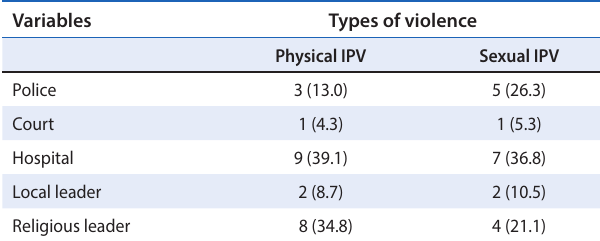
Table 6: Respondents’ sources of help Variables Types of violence